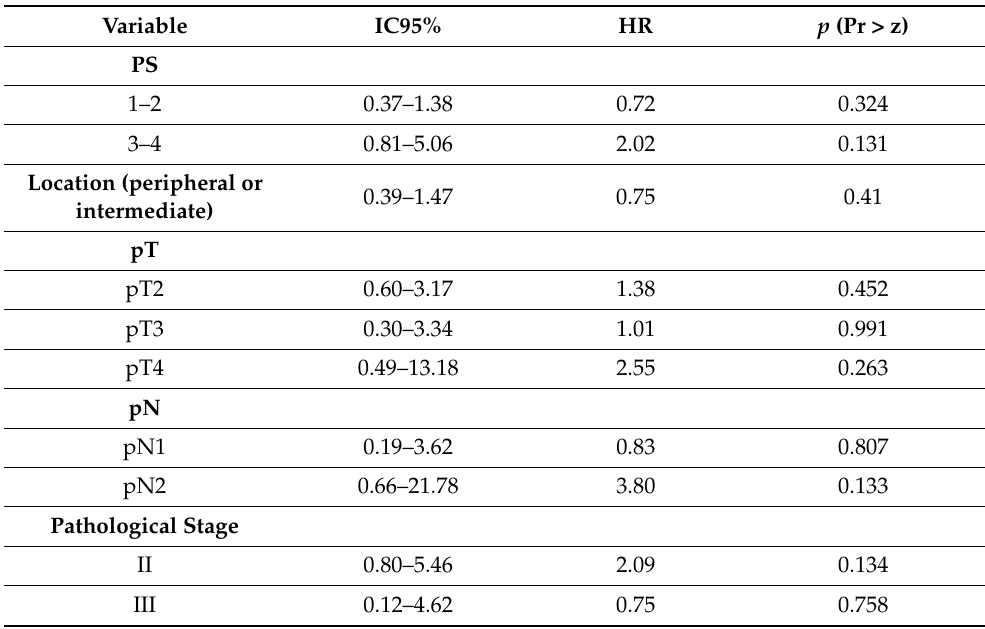
Table 4. Multivariate analysis of survival for clinical and pathological